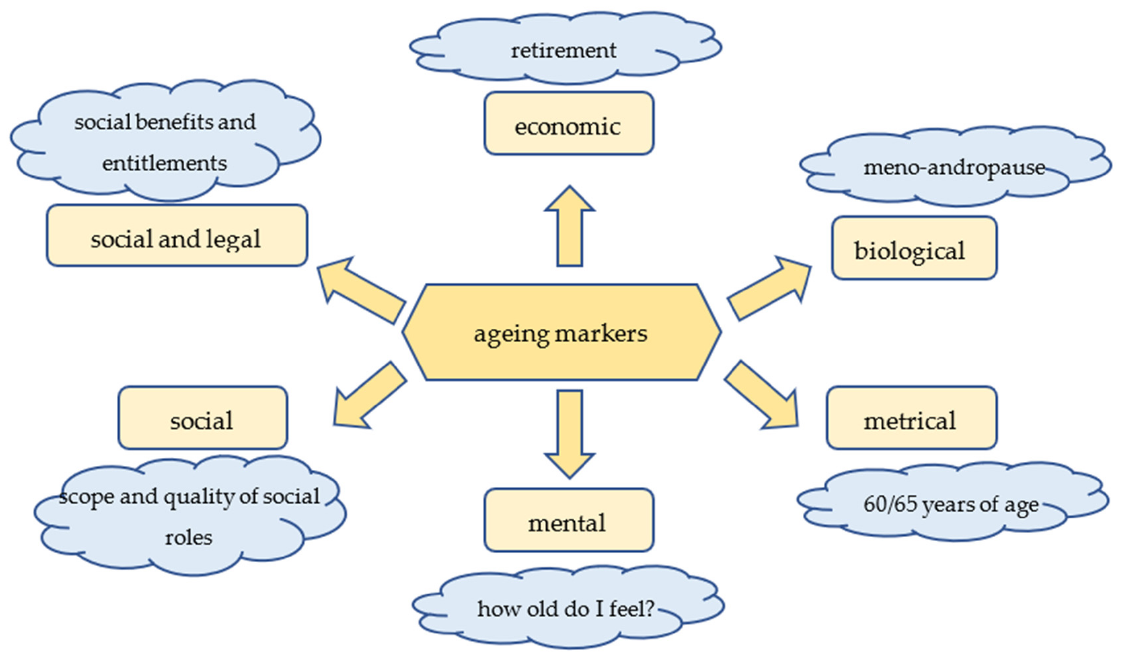
Figure 1. Aging markers. Source: own elaboration based on [21].